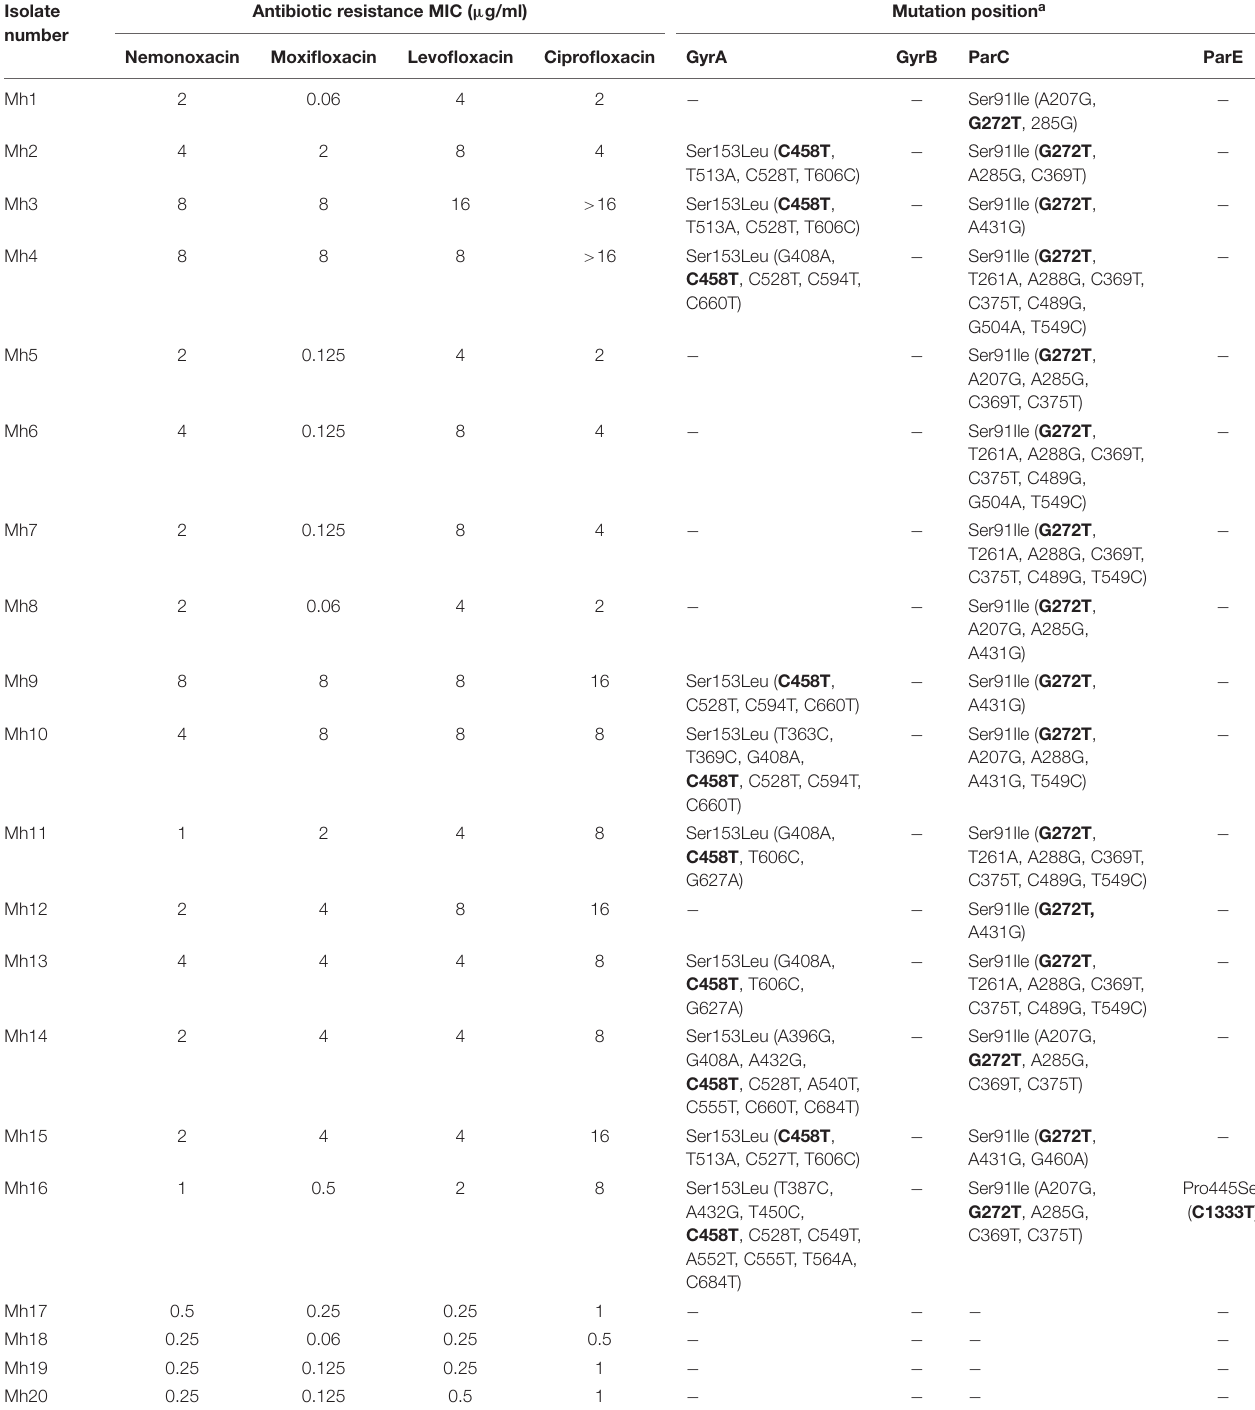
TABLE 3 | Gene point mutation and amino acid changes in GyrA, GyrB, ParC, and ParE in the Mh clinical isolates. Isolate